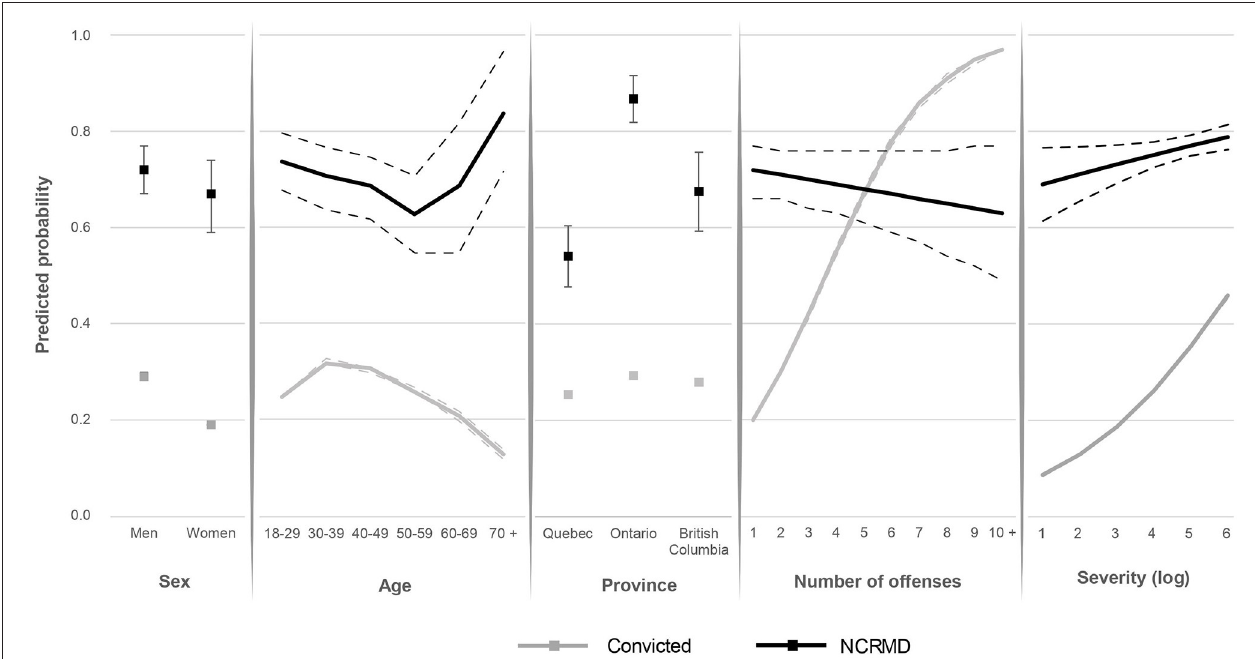
FIGURE 1 | Predicted probabilities of detention for NCRMD and convicted offenders by sex, age, province, number of offenses, and offense severity a . – Represent confidence